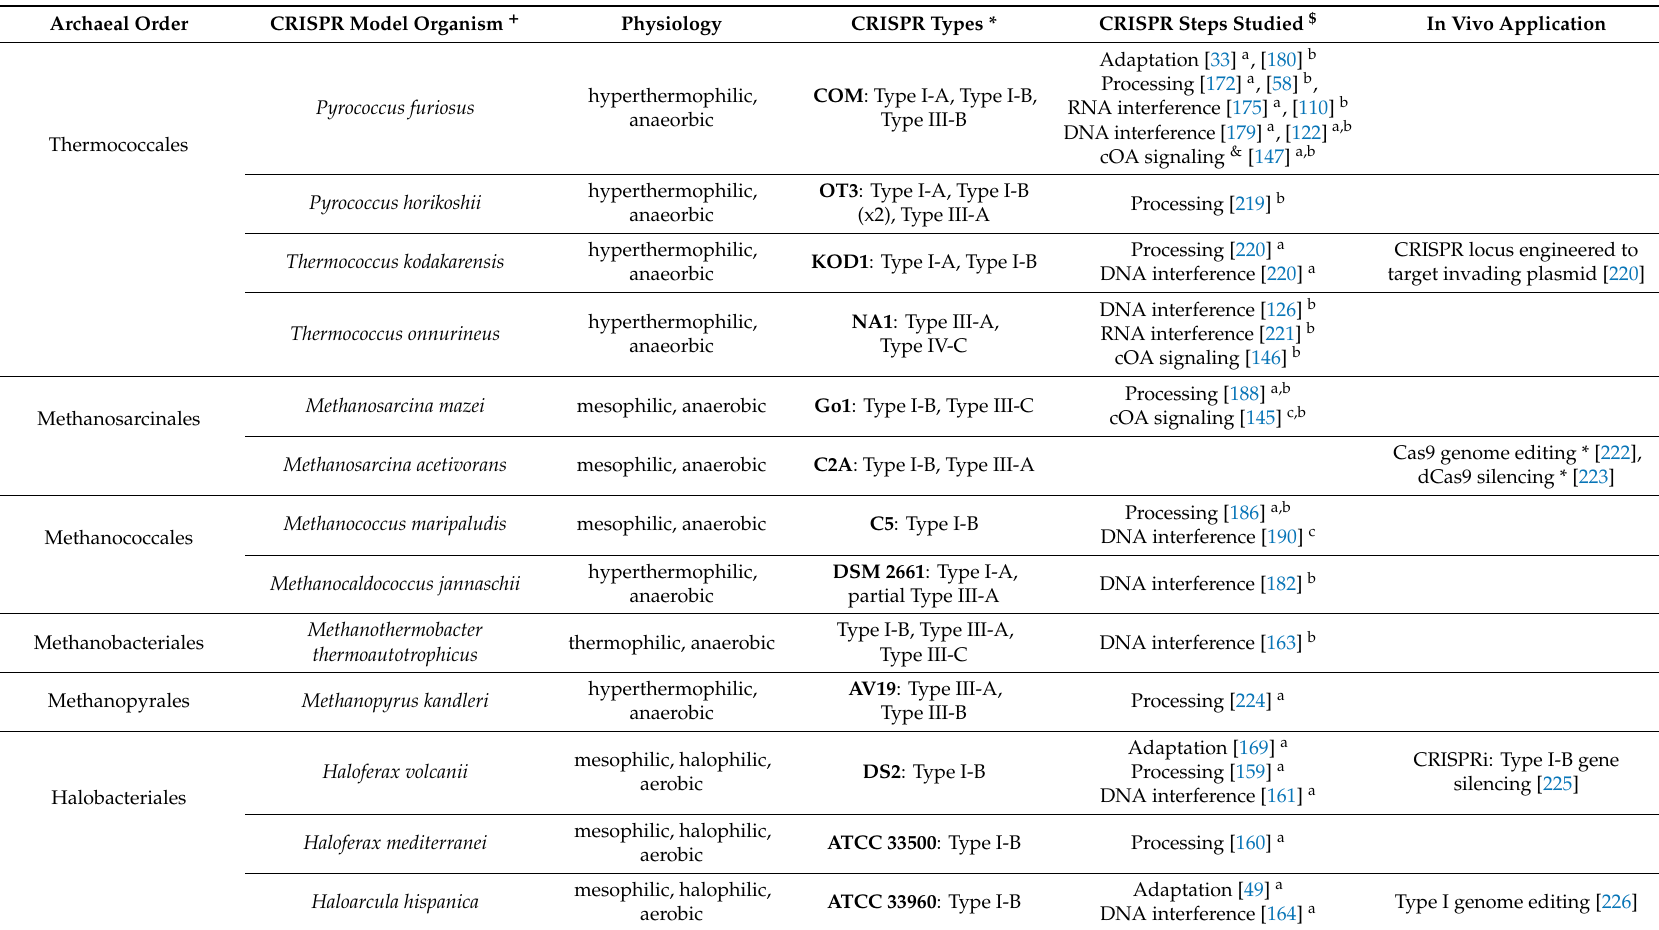
Table 1. Widely used archaeal model organisms for CRISPR in vitro and in vivo studies. Pioneer studies regarding the respective CRISPR step performed in each model organism are